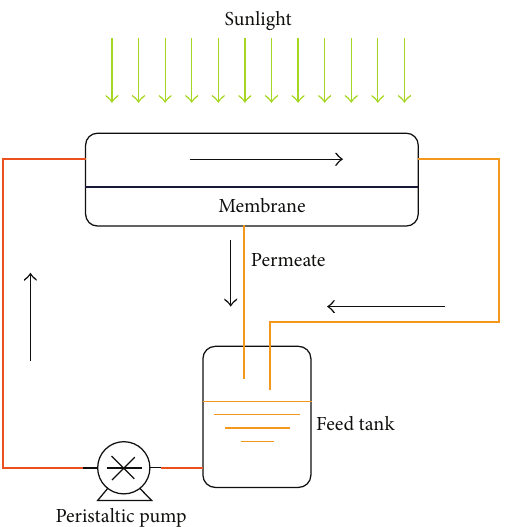
Figure 1: A schematic diagram of the photocatalytic membrane reactor (active membrane area is 2700 mm 2